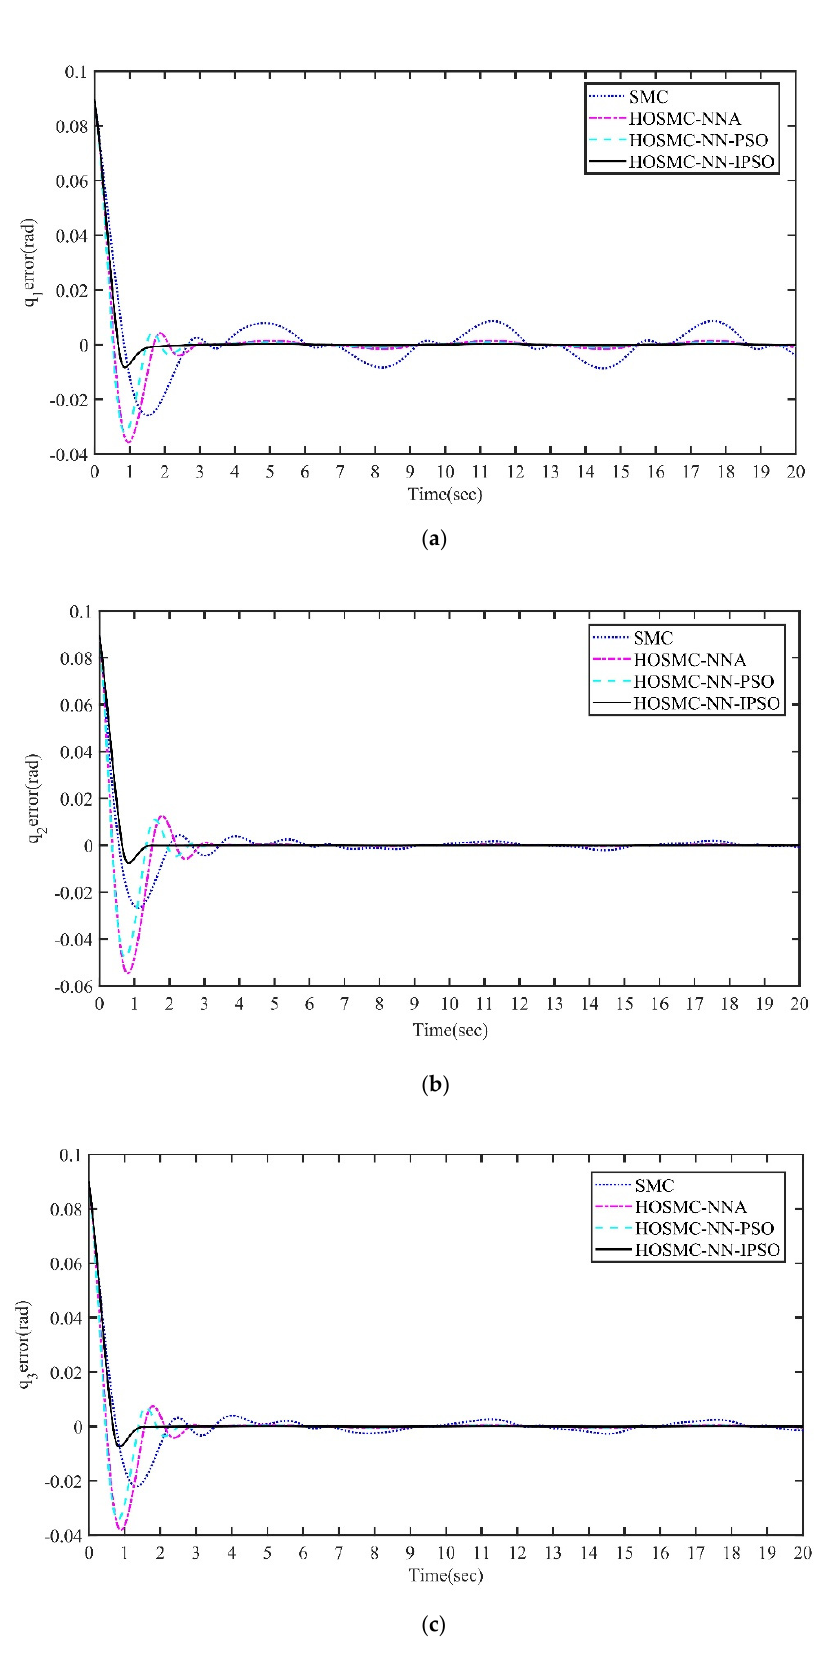
Figure 5. Position tracking error of the joints under the SMC, HOSMC − NNA, HOSMC − NN − PSO and HOSMC − NN − IPSO controllers. ( a ) Position tracking error of the joint 1. ( b ) Position tracking error of the joint 2. ( c ) Position tracking error of the joint